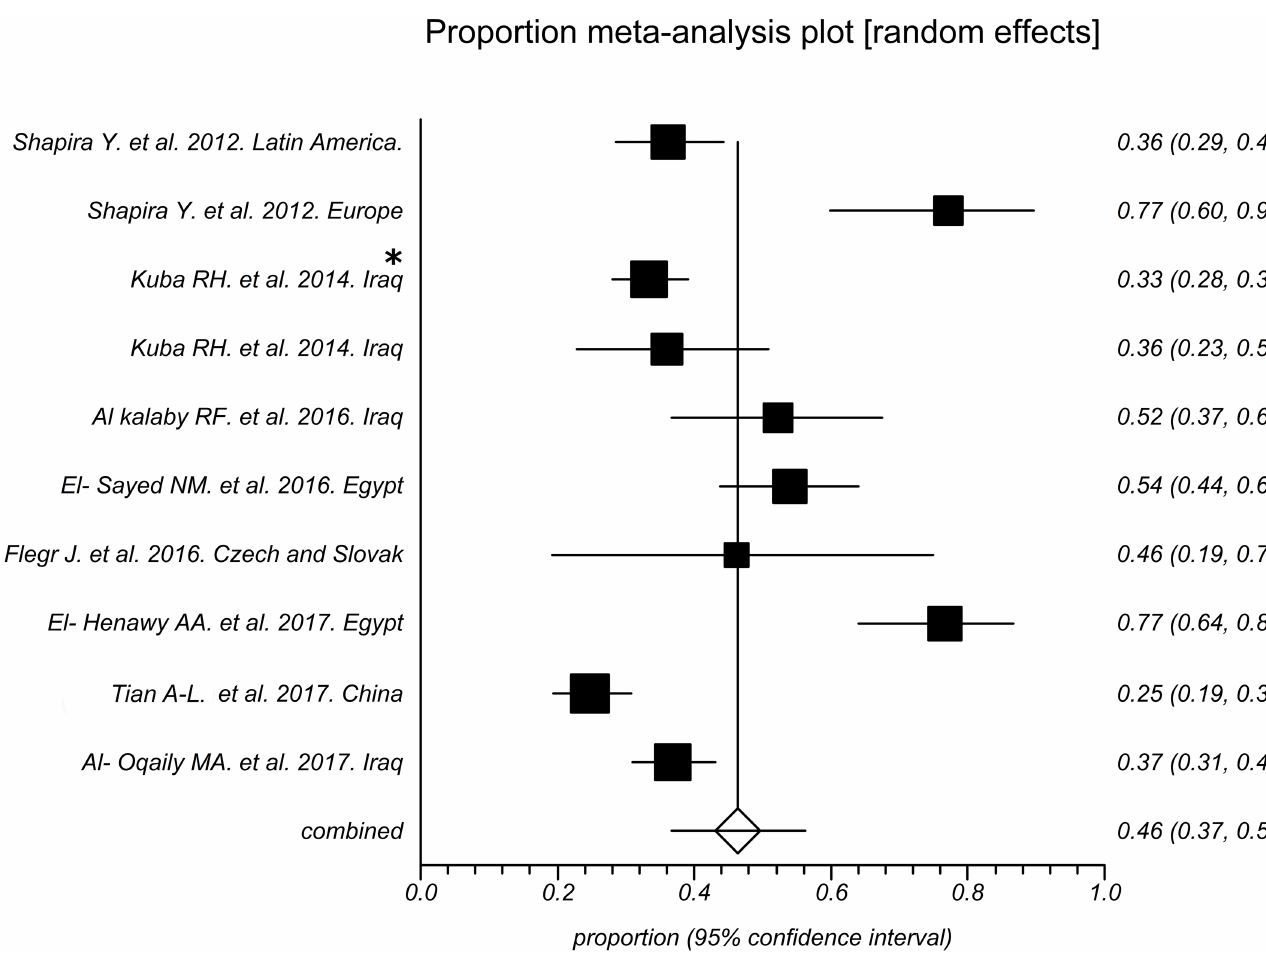
Fig 2. Forest plot of seroprevalence rates of toxoplasmosis in rheumatoid arthritis patients. (cid:3) Patients under treatment.